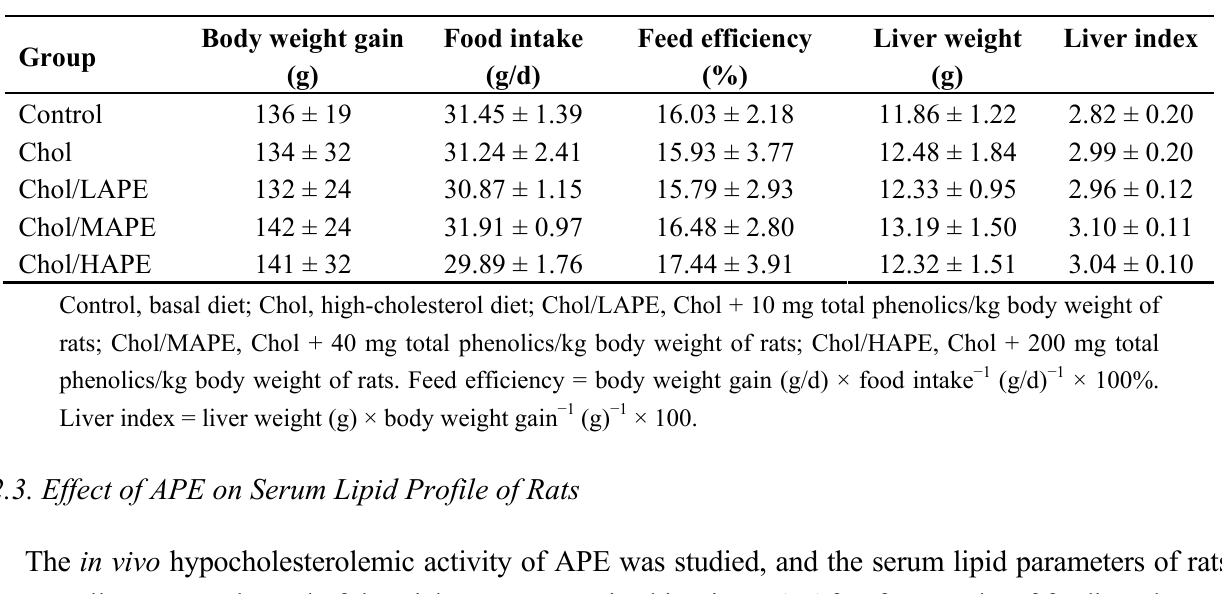
Table 1. Body weight gain, food intake, feed efficiency, liver weight, and liver index of